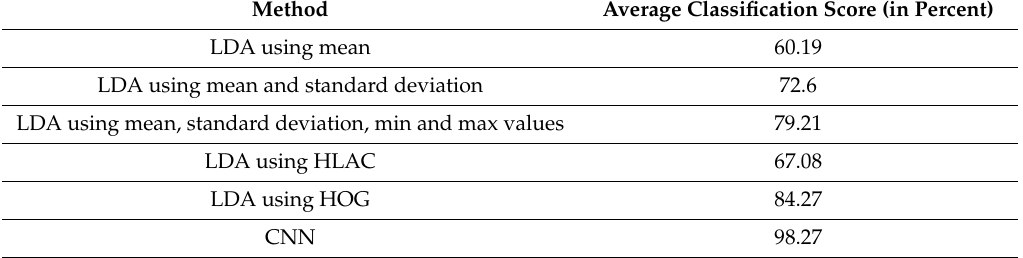
Table 1. Average classification scores for linear discriminant analysis (LDA) with di ff erent metrics and